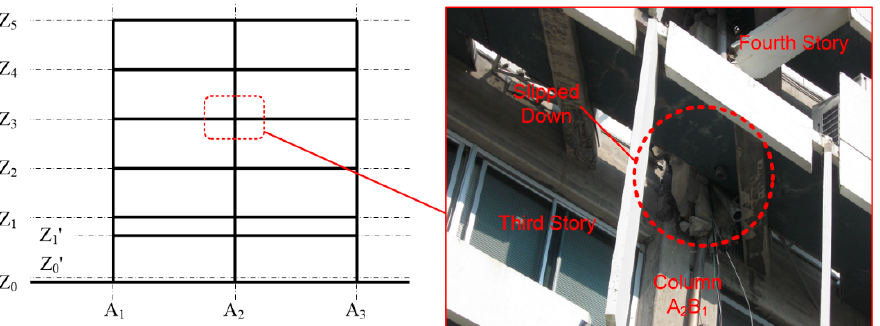
Figure 6. Failure of the beam-column joint above the column A 2 B 1 in the third story.